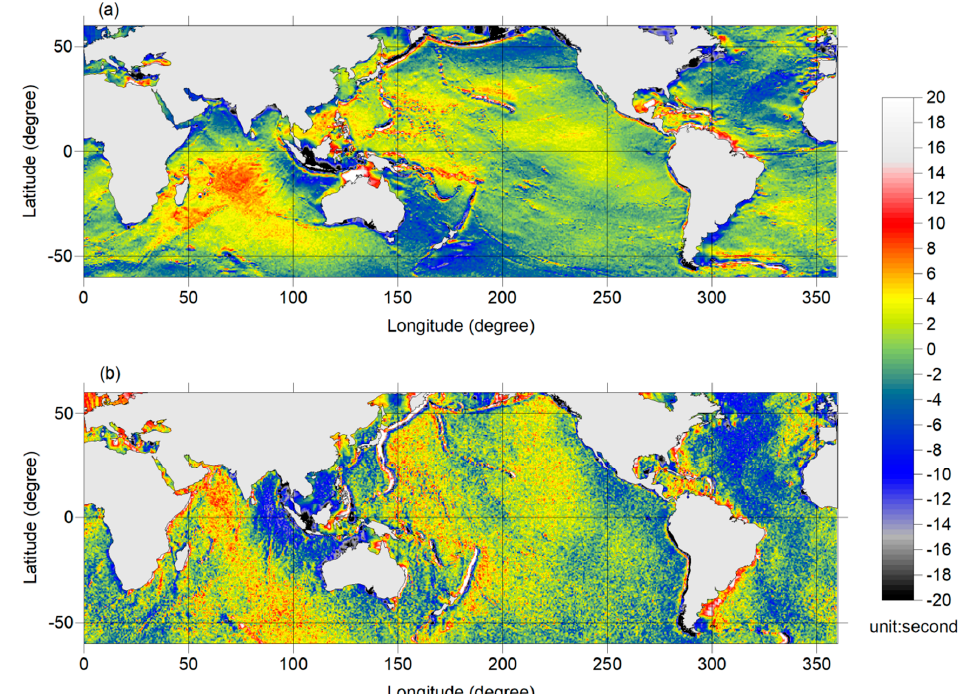
Figure 2. Vertical deflections derived from HY-2A observations: ( a ) North component; ( b ) East component.